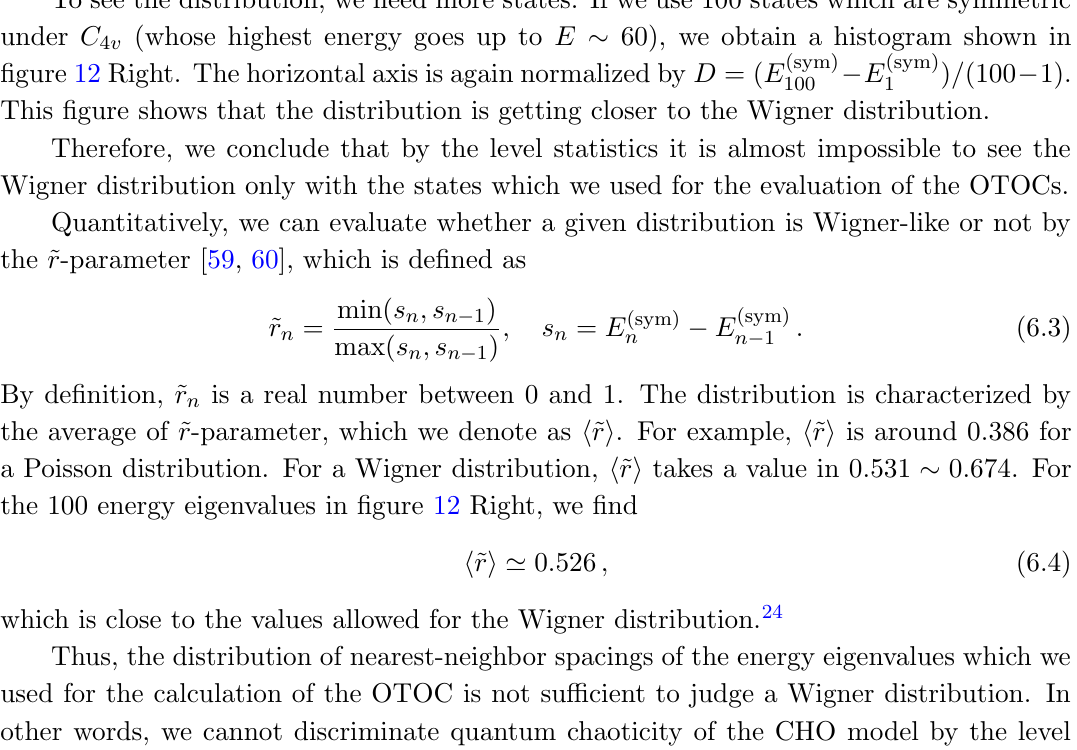
Figure 12 . Histograms for the nearest-neighbor spacings of energy eigenvalues from E (sym) (Left) and E (sym) to E (sym) (Right) . The horizontal axis is the nearest-neighbor spacing S E (sym) 35 1 100 normalized by its average value D over the chosen energy